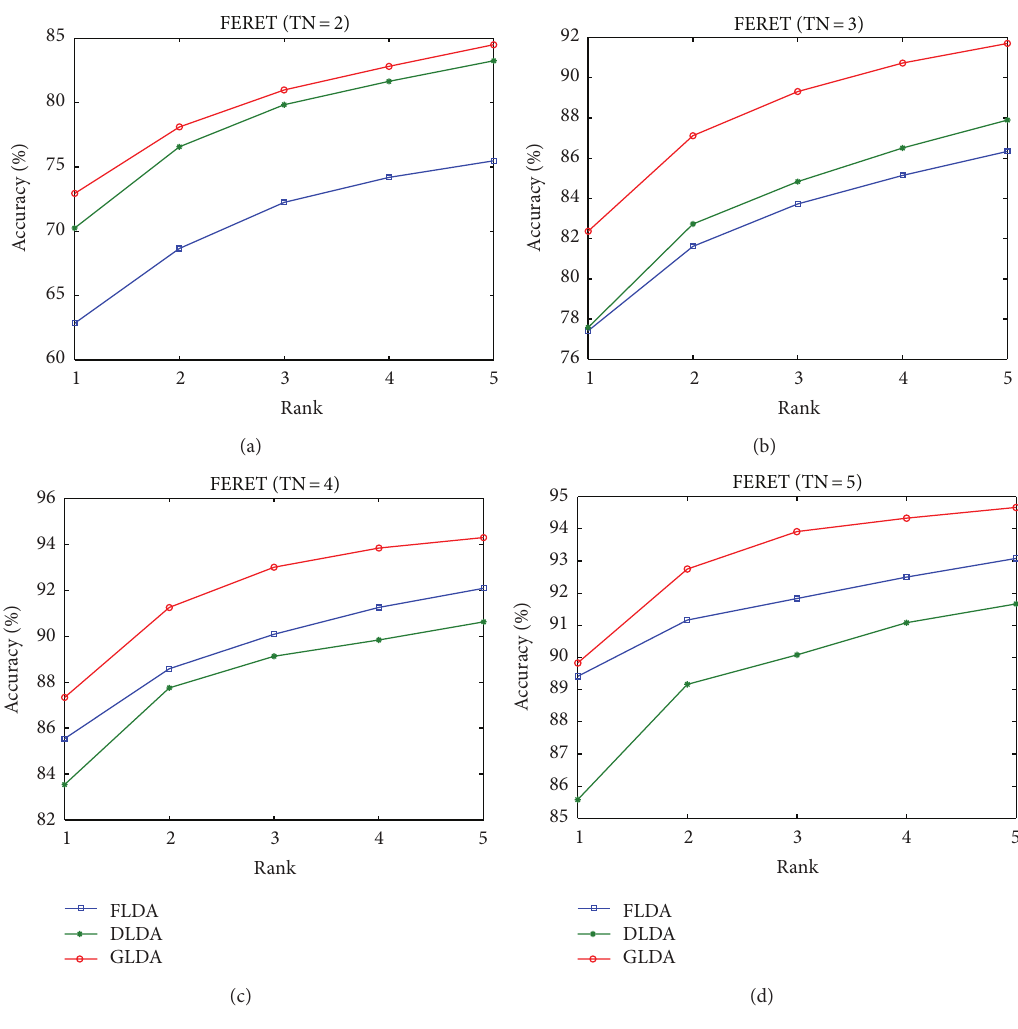
Figure 6: CMC curve comparisons on the FERET